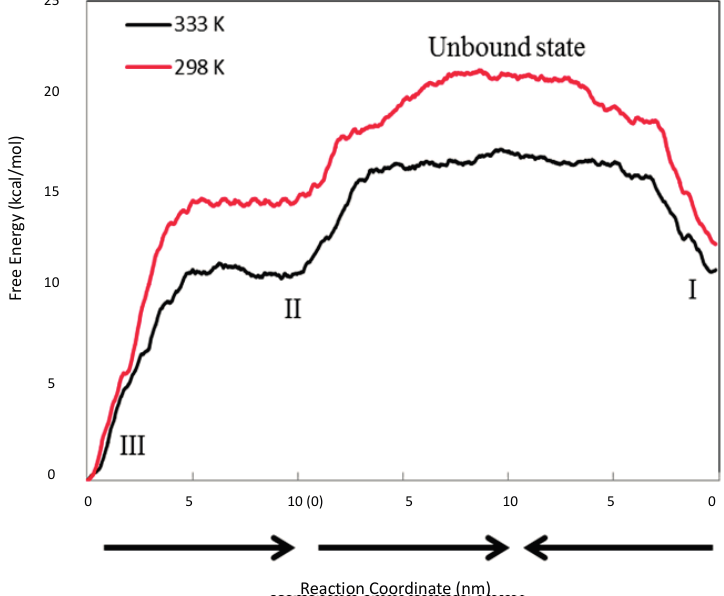
Figure 7. Free energy profile between Complexes I, II, III and the unbound state. The black line is at 298 °K, while the red line is at 333 °K. The reaction coordinate (the X -axis) is the distances between the two objects pulled apart in the steered MD runs. The arrows indicate the directions of three steered MD runs, which are from III to II, from II to the unbound state and from I to the unbound